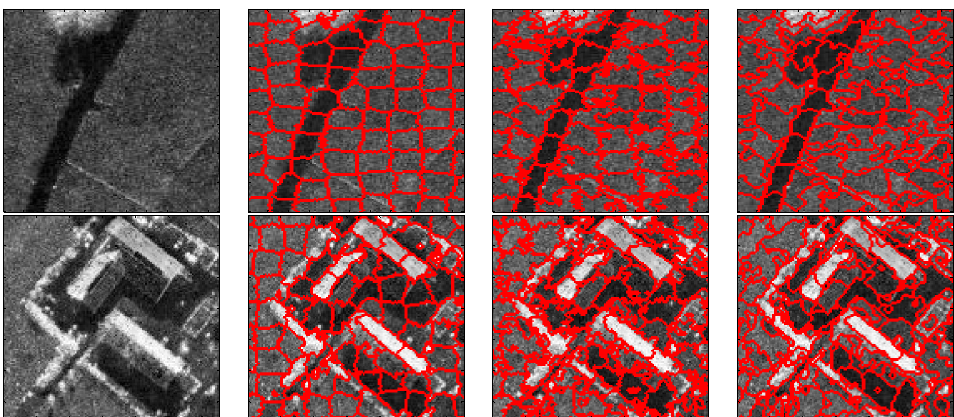
Figure 15. F-SAR image patches D1 and D2 (first column from top to bottom) and corresponding superpixels provided by standard SLIC (second column), compound method (third column), and proposed algorithm (fourth column).